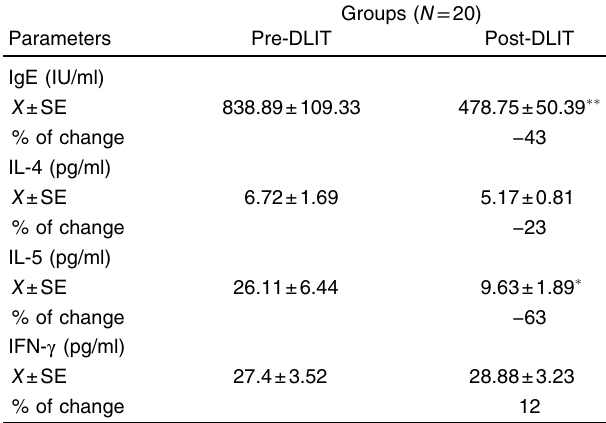
DLIT, diode laser inferior turbinoplasty; IFN, interferon; IgE, immunoglobulin E; IL, interleukin. Statistically significant changes after DLIT. (cid:2) P < 0.05.